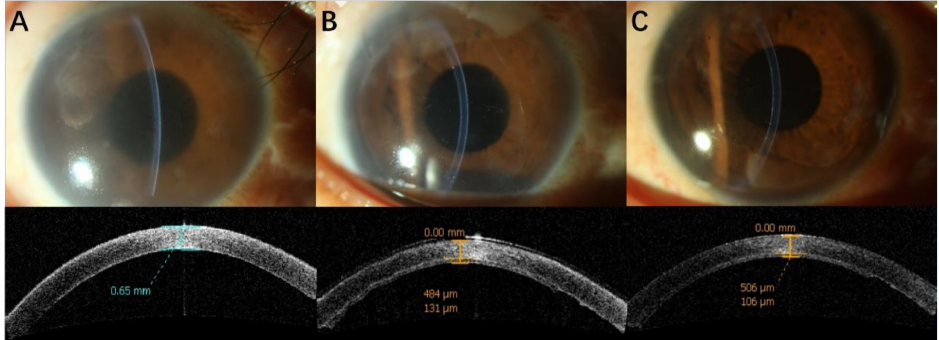
Figure 1. Clinical photographs and AS-OCT of a patient in group 1 before DSAEK ( A ) (CCT650 µ m), 1 month after DSAEK ( B ) (RCT484 µ m, GT131 µ m) and 12 months after DSAEK ( C ) (RCT506 µ m, GT106 µ